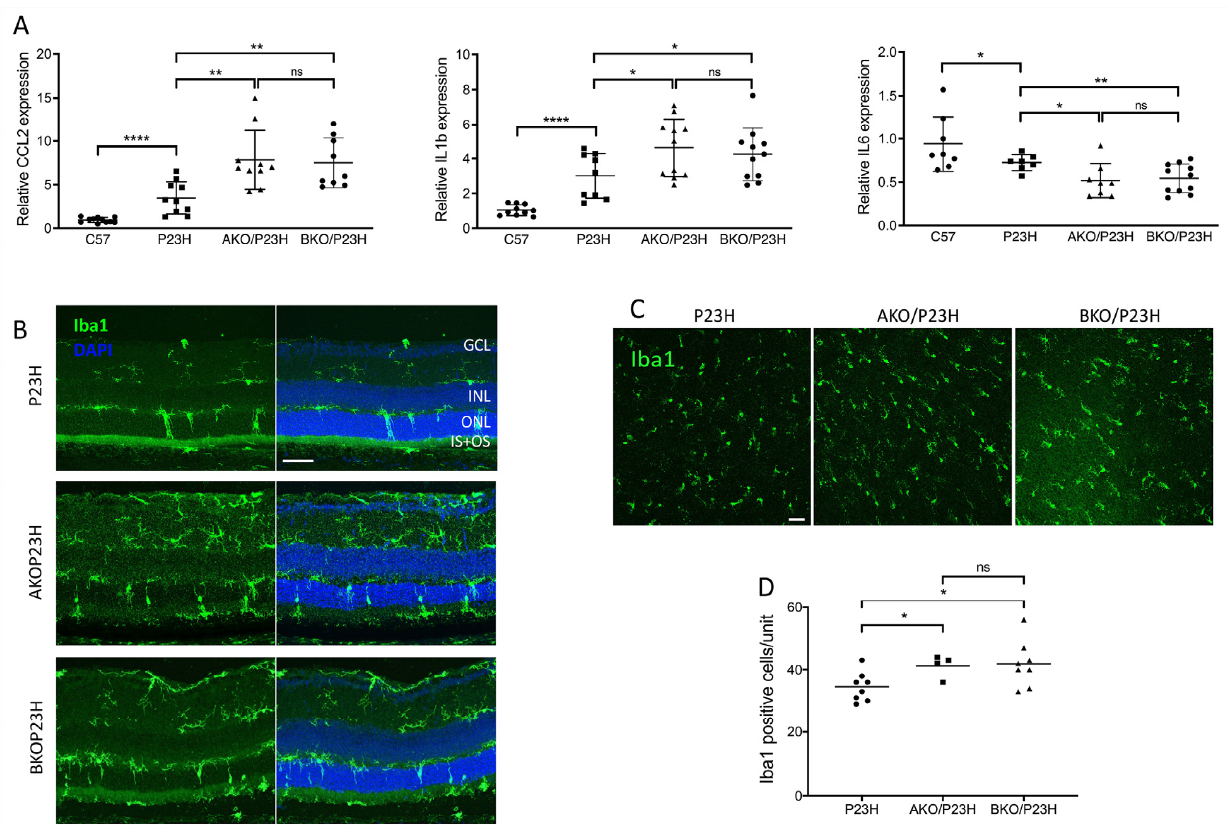
Figure 7. Further increased inflammation in the AKO/P23H and BKO/P23H mouse retina. ( A ) Transcript levels of inflammatory cytokines CCL2, IL1b, and IL6, in retinas of AKO/P23H, BKO/P23H, and P23H mice at two months of age, normalized to levels in the wild-type C57 mice (n ≥ 7). ( B ) Representative immunostaining images of retinal sections from inferior retinas of AKO/P23H, BKO/P23H, and P23H mice at two months of age stained with Iba-1 and DAPI. ( C ) Representative images for ONL from retinal whole mount of AKOP23H, BKOP23H and P23H mice stained with Iba1 at two months of age. ( D ) Quantification of Iba1-positive cells in the ONL and subretinal space of the inferior retina of AKO/P23H, BKO/P23H and P23H mice. (n ≥ 4 ), * p < 0.05; ** p < 0.01; **** p < 0.0001; ns, not significant. One-way ANOVA. GCL, ganglion cell layer, IPL, inner plexiform layer, INL, inner nuclear layer, ONL, outer nuclear layer; IS/OS, inner and outer segment. Scale bar: 50 µm.